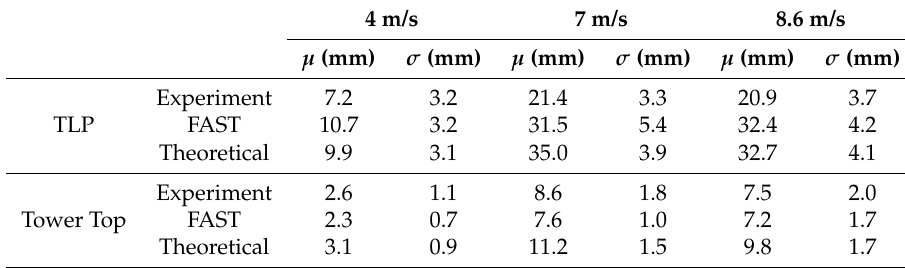
Table 7. The mean ( µ ) and standard deviation ( σ ) of the displacement in surge of the TLP and tower top at simultaneous wind and wave loading. The wind speeds which is tested at is 4 m/s, 7 m/s and 8.6 m/s and monochromatic waves with a wave height of 0.01 m and wave frequency of 0.6